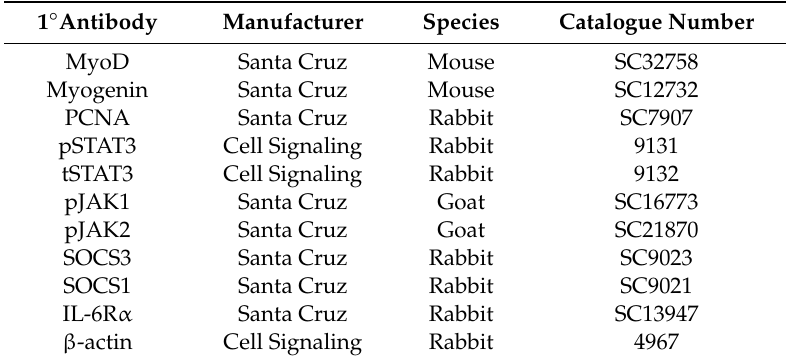
Table 1. Primary antibodies utilized for western blotting and immunocytochemistry.